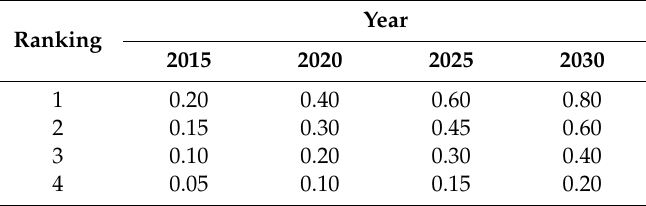
Table 7. Weights of the di ff erent rankings for each